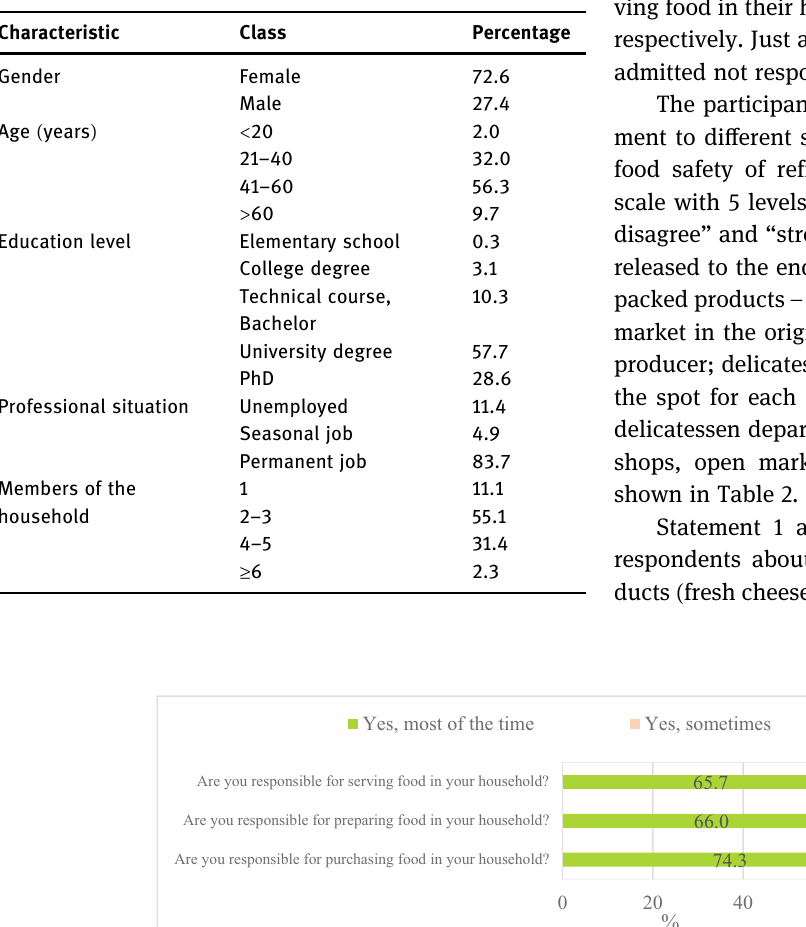
Table 1: Sociodemographic characterization of the sample ( N = 350 )